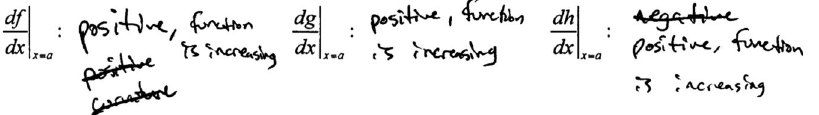
FIG. 4. Example of student response to derivative sign task that started to use 2nd derivative reasoning—note the ‘‘positive curvature’’ in the response—but switched to the correct reasoning.